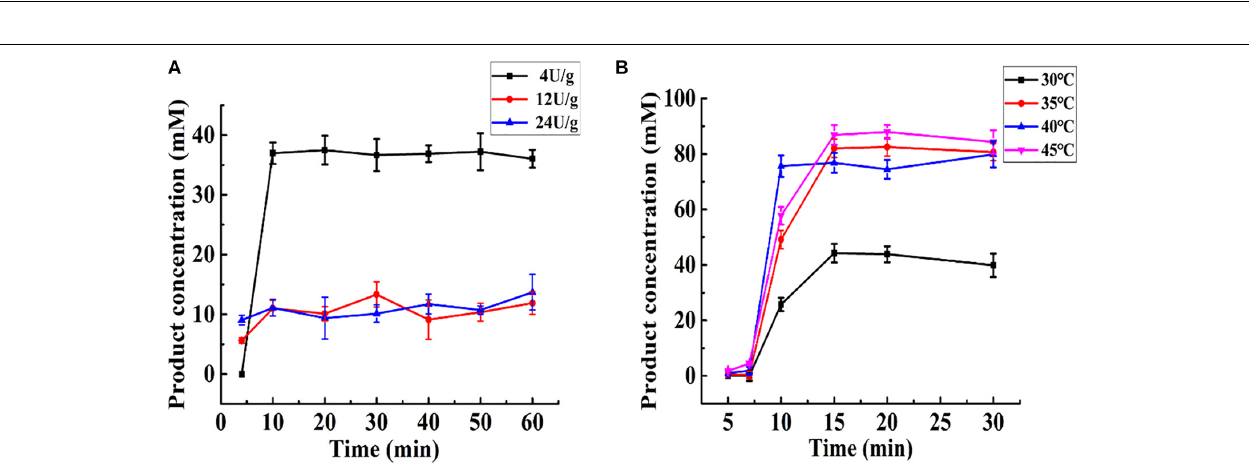
FIGURE 4 | Scanning electron images (5.0 kV, 2,400 × ) showing the morphology image of agarose spheres before (A) and after (B) Aga-ASNase immobilization. (C) Fourier transform infrared (FTIR) spectra of unbonded agarose and agarose bonded with ASNase.